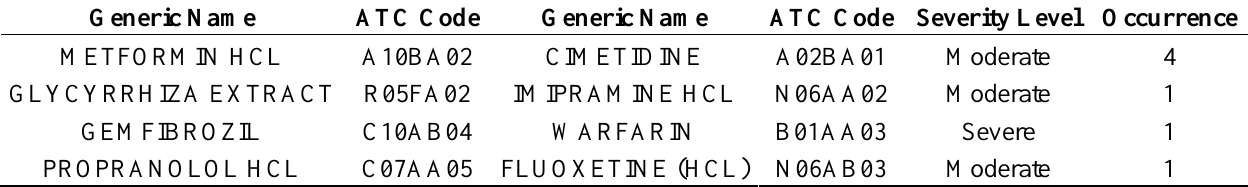
Table 3. The occurrences of DDI drug pairs during the study